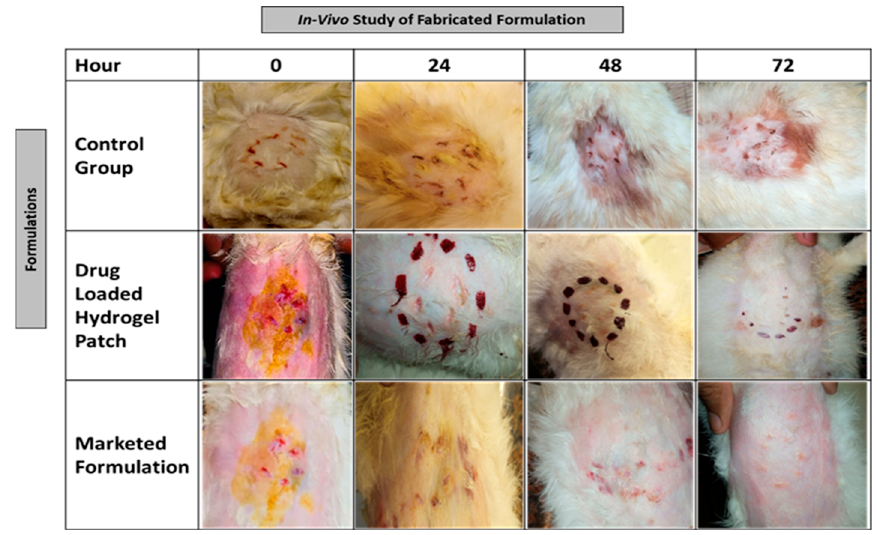
Figure 11. Healing performance of optimized drug-loaded formulation with control group and marketed formulation.